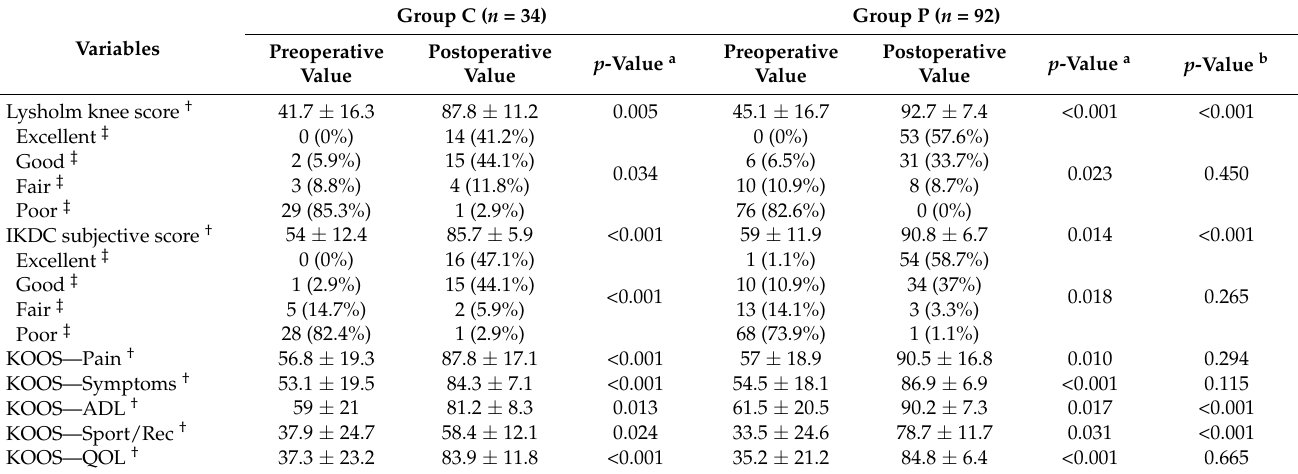
Table 3. Comparison of functional outcomes between the preoperative and postoperative values in each group.